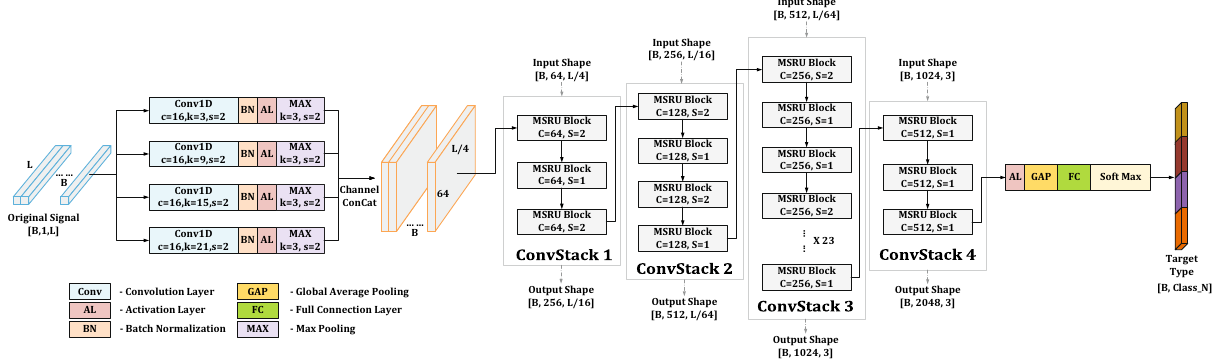
Figure 3. The structure of multiscale residual deep neural network (MSRDN). The shape of input data is [ B , 1, L ], in which B represents batch size and L represents data length. The shape of output is [ B , Class _ N ] , in which B represents batch size and Class _ N represents the number of predicted categories. In the head of the network are four parallel convolution with different kernel size. the main body of MSRDN is stacked by MSRU. According to the difference of hyper-parameter C , all MSRUs will be divided into four convolution stacks. The convolution stacks can be directly connected to each other due to the independence and flexibility of